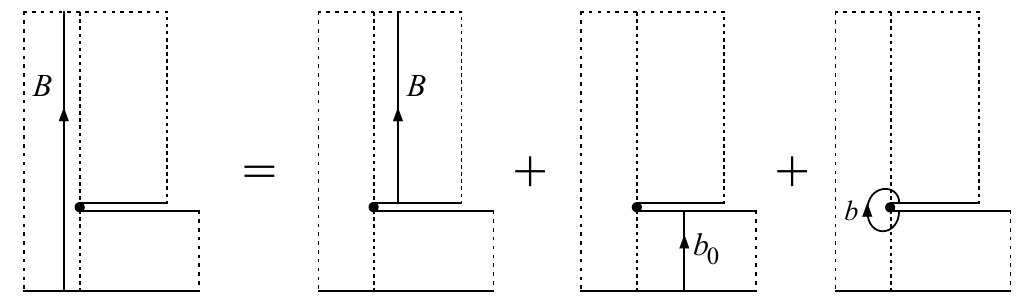
Figure 14 . Deforming the vertical contour integral corresponding to B through a (cid:13)ag state pro- duces three contributions, including a nontrivial contribution from integrating the b -ghost around the